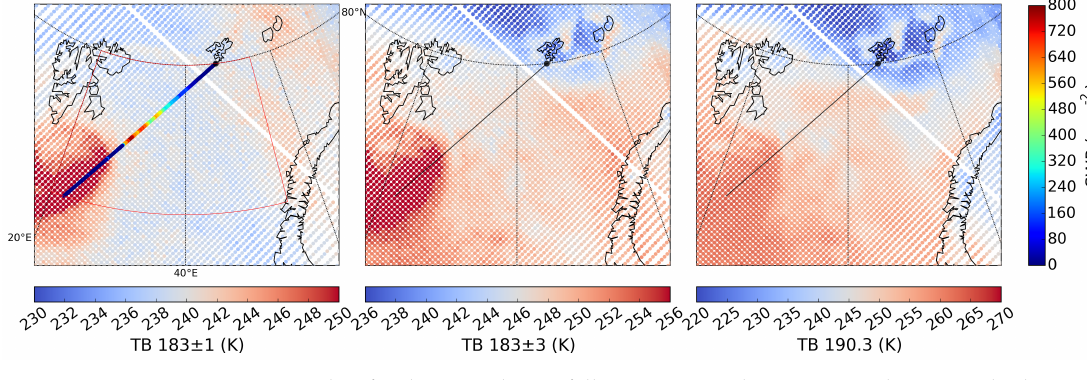
Figure 7. Same as Figure 5, but for the second snowfall case presented in Figure 6. The SWP color bar scale is different from that in Figure